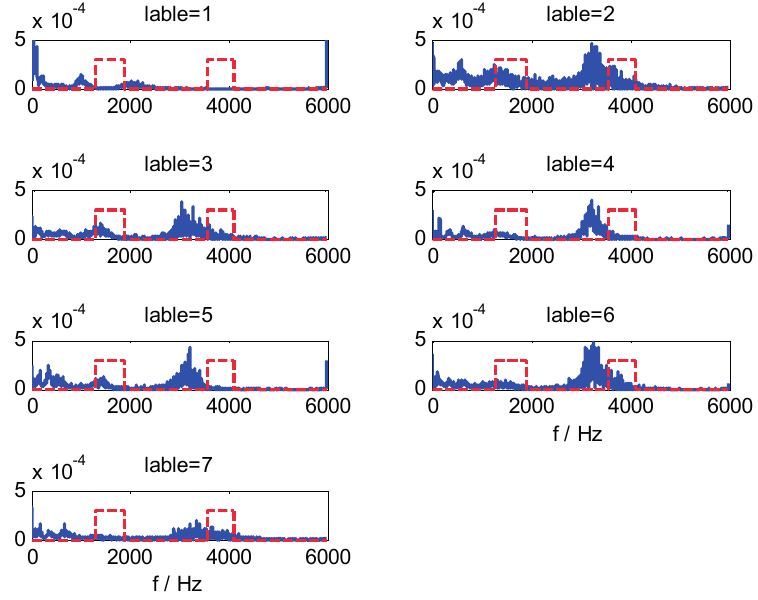
Figure 8. The extracted HMS-CFBs of samples in different kinds of fault